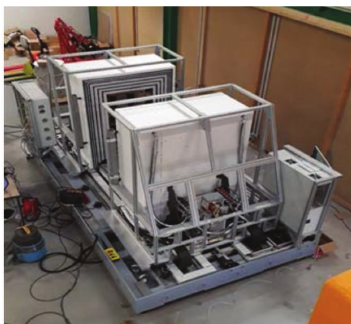
Fig. 2. The CHANCE calorimeter at the SCK − CEN being tested with real waste packages.